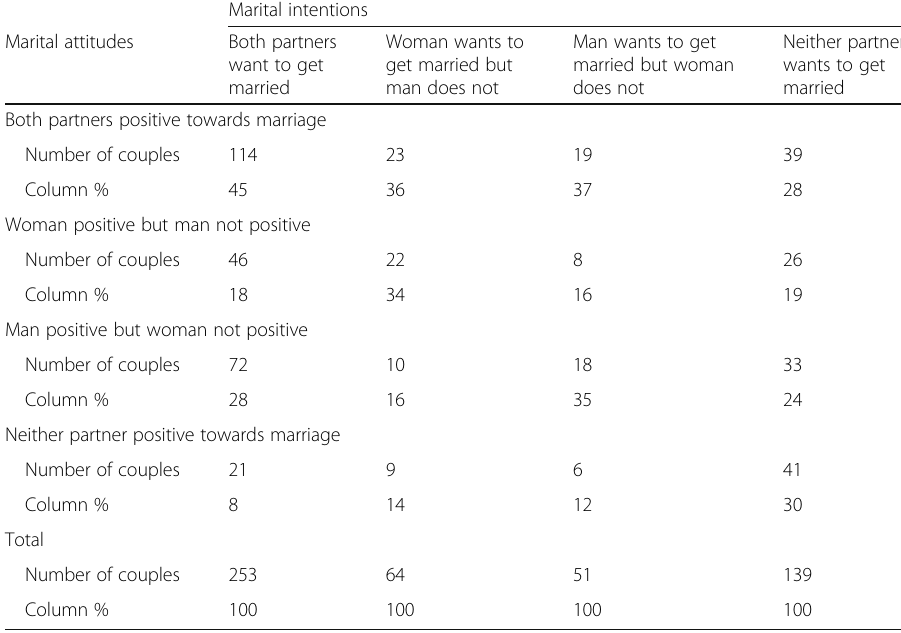
Table 2 Cross-tabulation between marital intentions and marriage attitudes (index) Marital intentions Marital attitudes Both partners want to